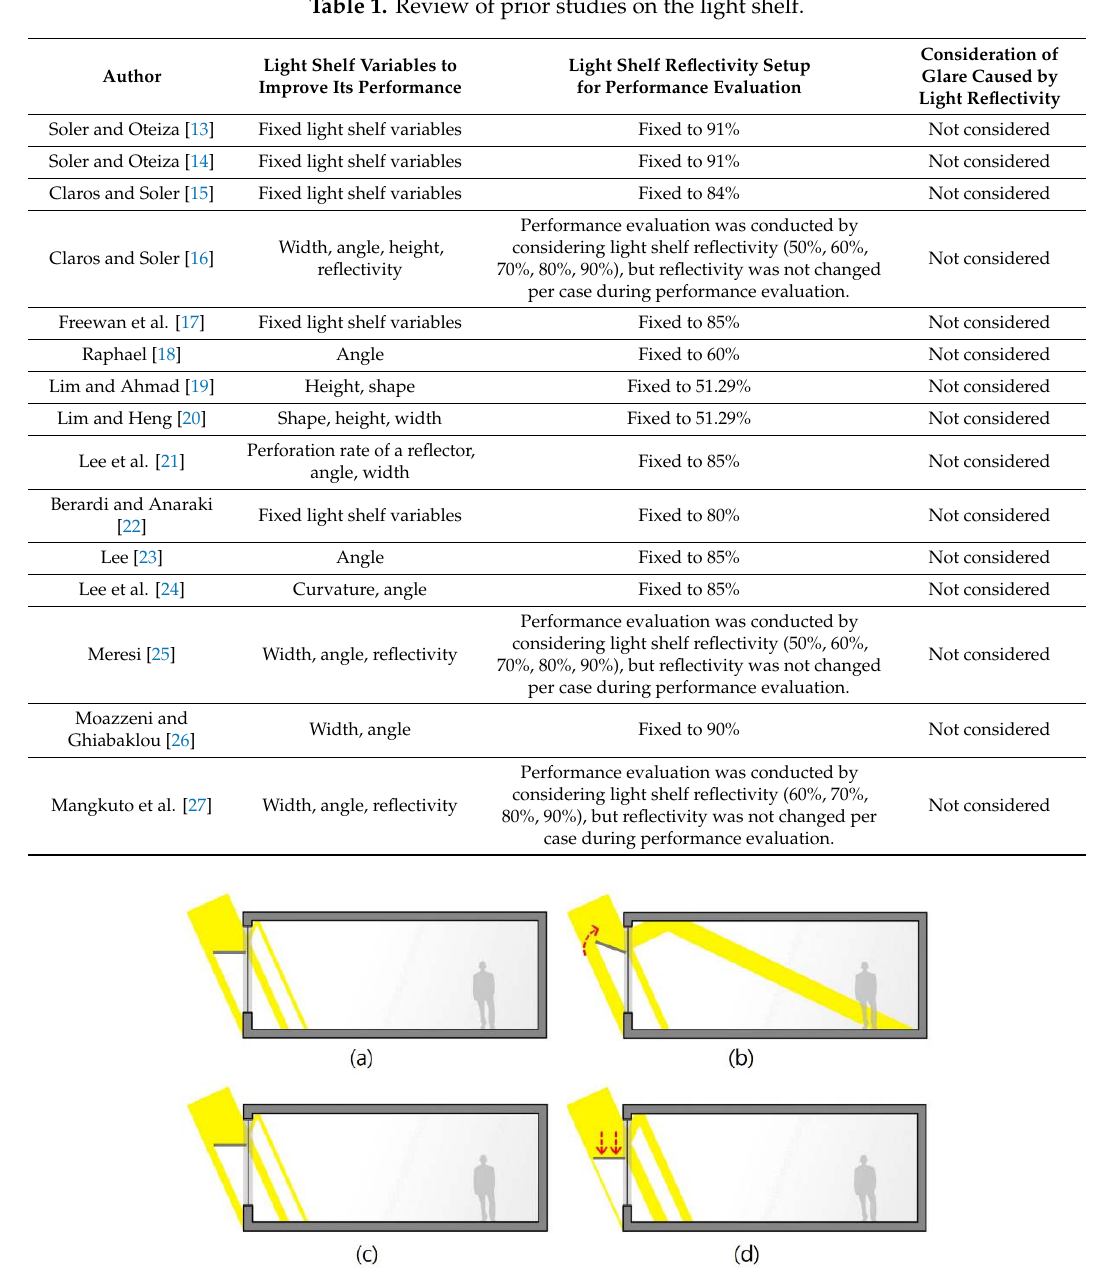
Figure 2. Natural light entering a room depending on light shelf angle and height: ( a ) natural light entering a room when light shelf angle is 0°; ( b ) natural light entering a room when light shelf angle is 20°; ( c ) natural light entering a room when light shelf height is 1.8 m; ( d ) natural light entering a room when light shelf height is 1.5 m.